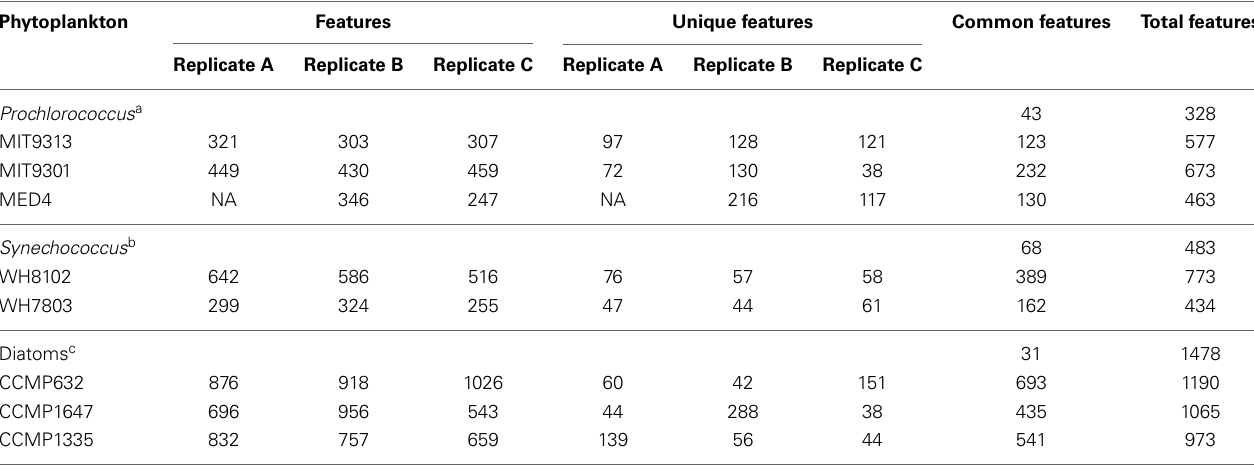
Table 1 | DOM P features detected using HPLC-ESI-MS after blank